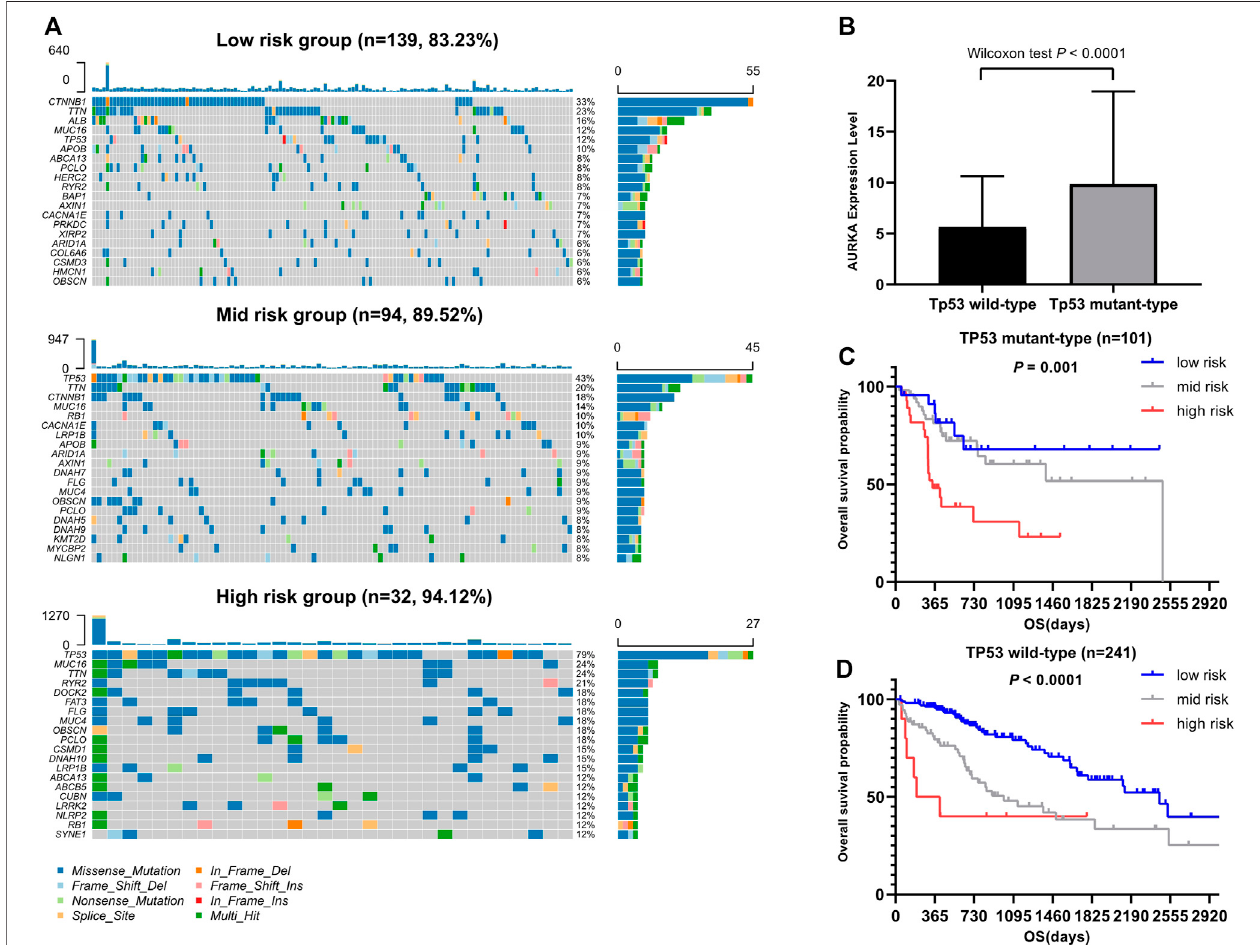
FIGURE 6 | Association between somatic mutation and risk score. (A) Overview of somatic mutations in different risk groups. (B) Comparison of AURKA expression between TP53 mutation group and Tp53 wild group. (C) Kaplan-Meier survival analysis of the different risk groups of TP53 mutation. (D) Kaplan-Meier survival analysis of the different risk groups of Tp53 wild.